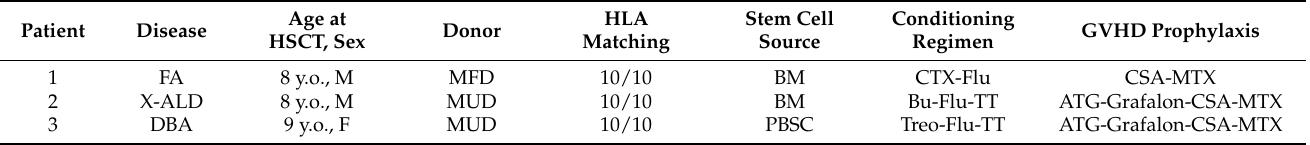
Table 1. Transplants’ characteristics.